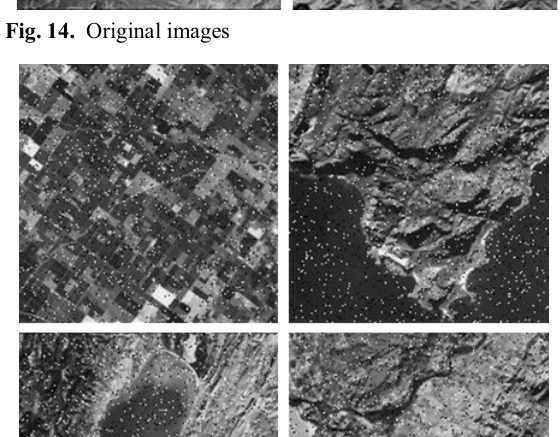
Fig. 14. Original images